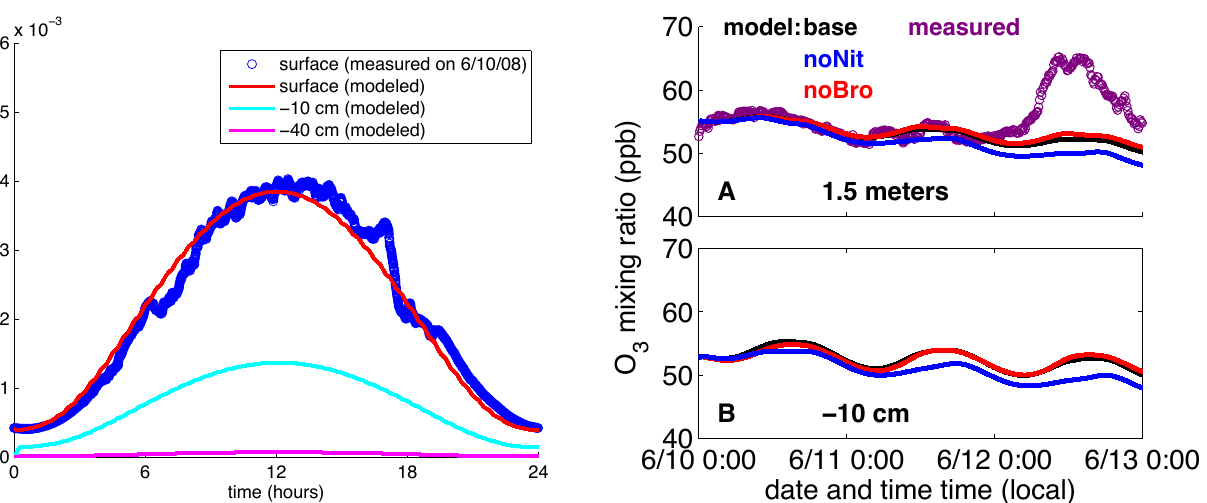
Fig. 6. Model predicted O 3 compared to measurements above the snow surface for a three day model run (10–13 June 2008) for the base, noNit, and noBro